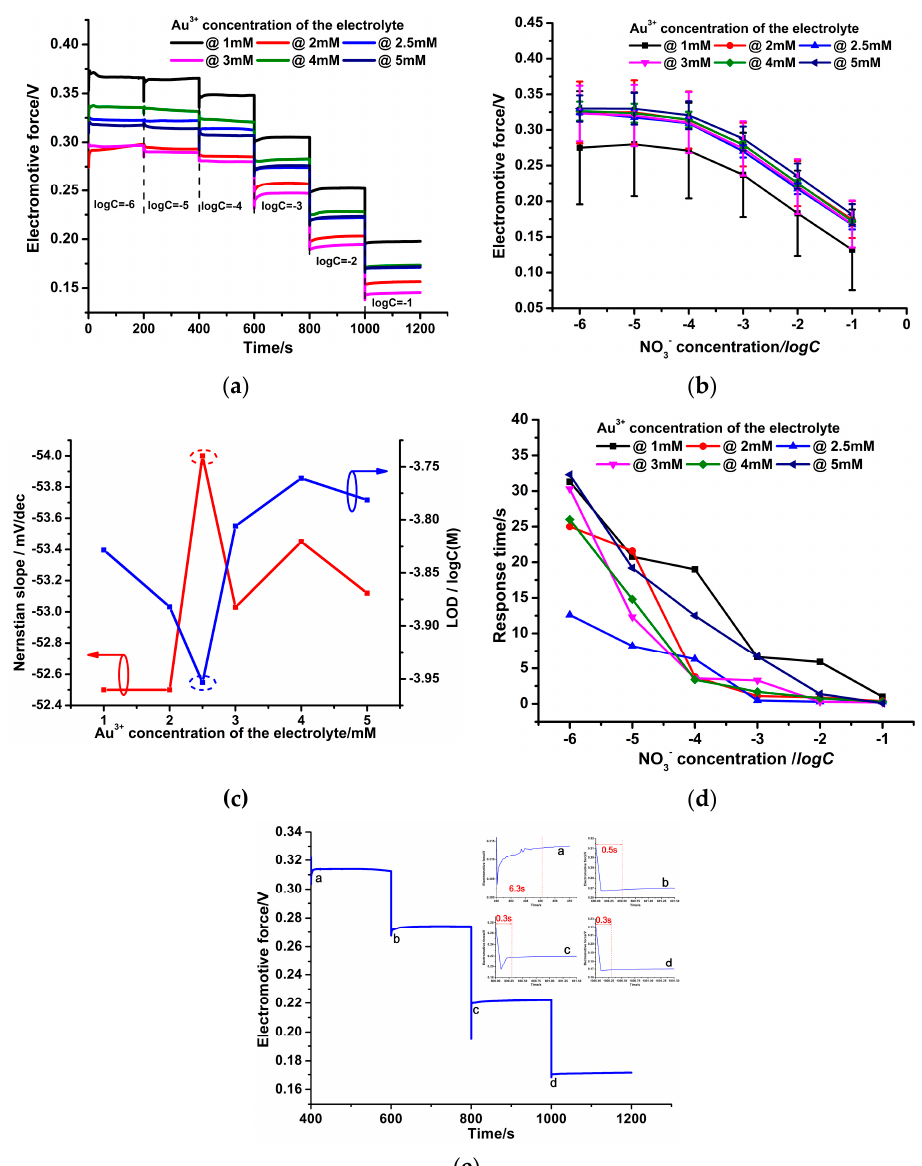
Figure 13. Time-dependent potential response traces of 6 freshly prepared PPy-Au-NS ISEs ( a ). EMF curves of 6 freshly prepared PPy-Au-NS ISEs, each curve was measured by 5 electrodes synthesized at the same parameters ( b ). Nernstian slope and low detection limit ( c ) as well as average response time ( d ) dependence on the logarithm of the activity of PPy-Au-NS ISE. Detailed response time of PPy-Au-NS ISEs at Au 3+ concentration 2.5 mM of the electrolyte ( e ).